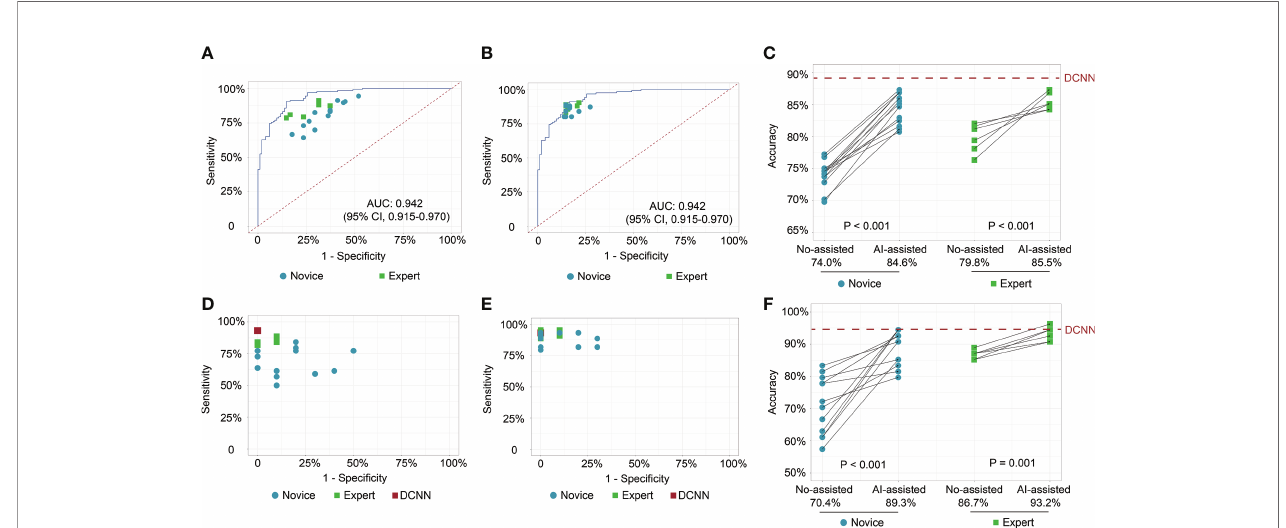
FIGURE 2 | Receiver operating characteristic curves and scatter plots illustrate the DCNN model ’ s ability and endoscopists in discriminating intramucosal GC. (A) Diagnostic performance of DCNN model and endoscopists without the assistance of DCNN model in the image testing datasets; (B) Diagnostic performance of DCNN model and endoscopists with the assistance of DCNN model in the image testing datasets; (C) Diagnostic accuracy of endoscopists in the subgroup with or without the assistance of DCNN model in the image testing datasets; (D) Diagnostic performance of DCNN model and endoscopists without the assistance of DCNN model in the video testing datasets; (E) Diagnostic performance of DCNN model and endoscopists with the assistance of DCNN model in the video testing datasets; (F) Diagnostic accuracy of endoscopists in the subgroup with or without the assistance of DCNN model in the video testing datasets.